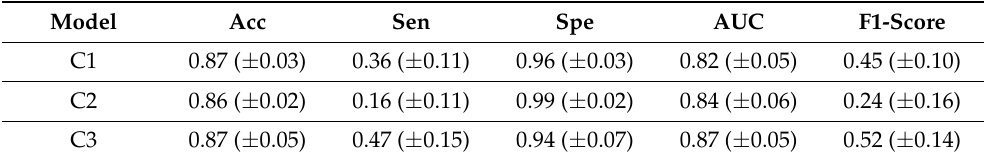
Table 8. Results for the models with K-fold CV for each test set of each fold with the mean of results of the models for the 5 folds and the standard